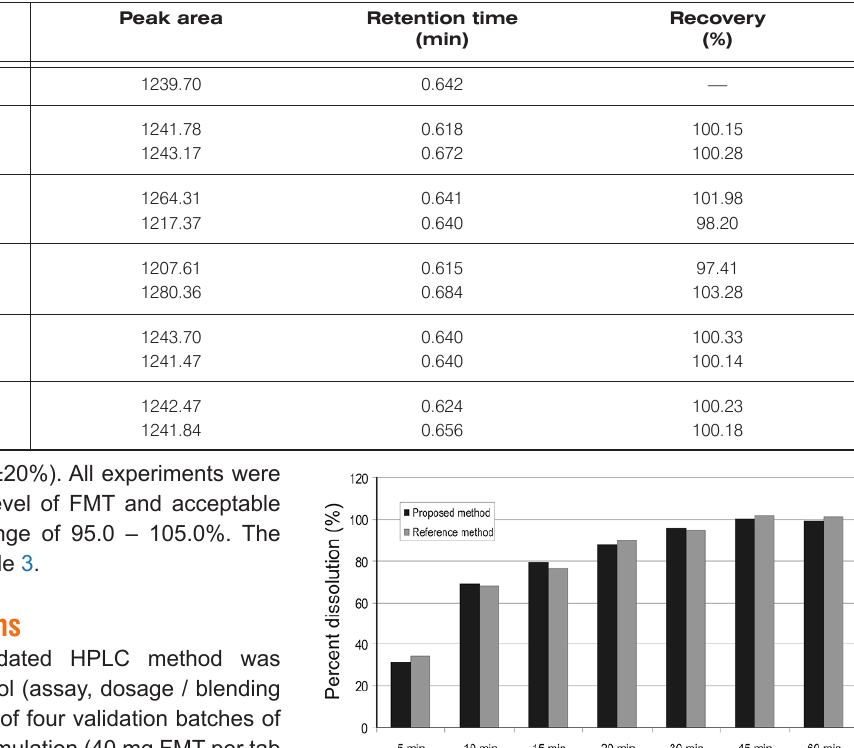
Table 3. Ruggedness of the HPLC